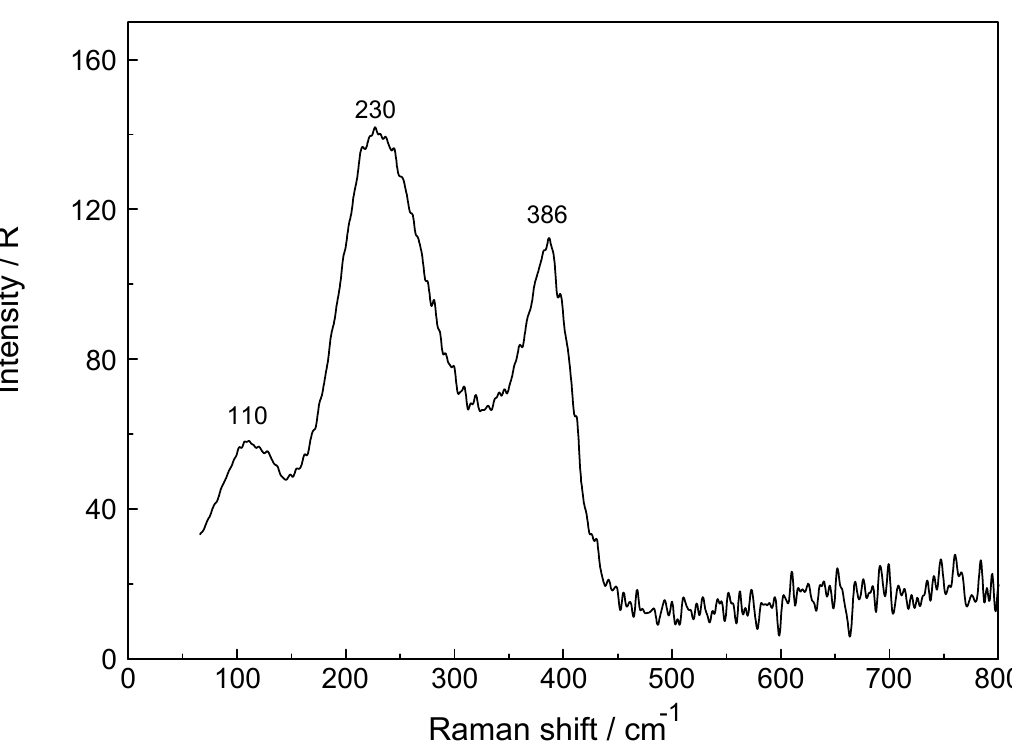
Figure 7. Isotropic Raman spectrum of a ternary LuCl 3 /HCl composed of 1.589 mol · L − 1 LuCl 3 plus 6.047 mol · L − 1 HCl from which the isotropic scattering profile of a 6.02 mol · L − 1 HCl solution was subtracted. The difference spectrum shows clearly that Cl − must have substituted water molecules of the first hydration sphere of Lu 3+ . Lu-O mode of the complex, [Lu(OH 2 ) 8 − n Cl n ] +3 − n ( n = 1, 2) and the broad mode at 230 cm − 1 with a shoulder at 263 cm − 1 and at 110 cm − 1 are due to the chloro-complex species.